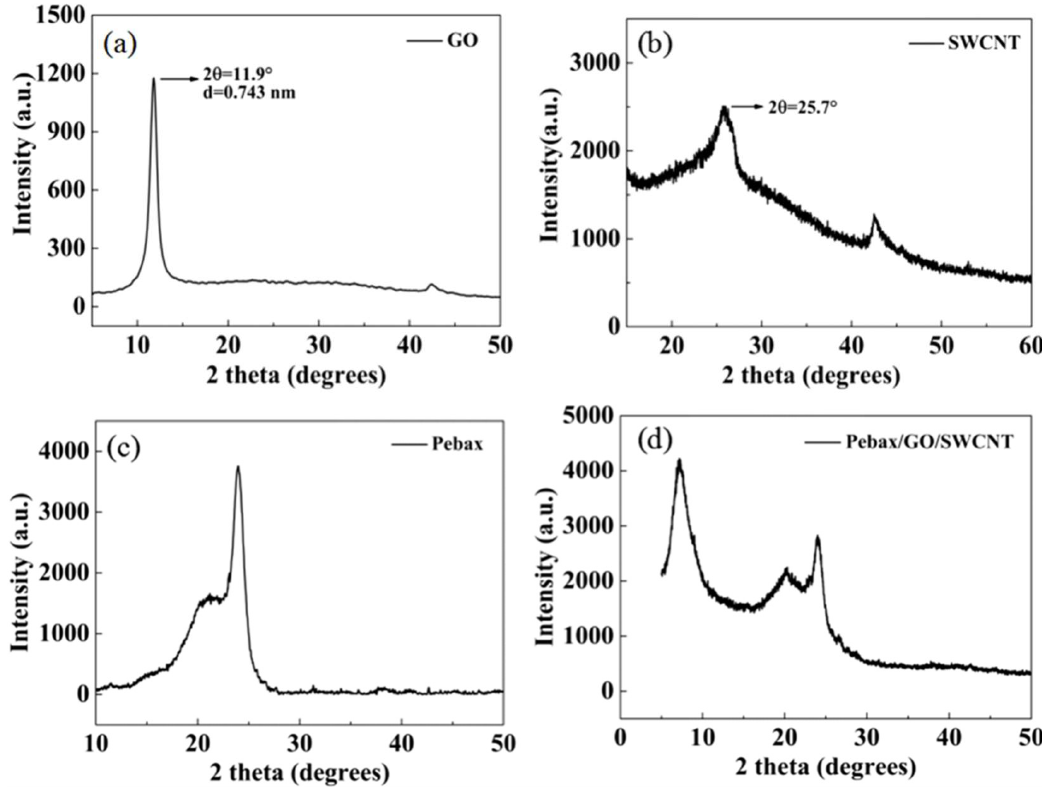
Figure 6. XRD of ( a ) GO, ( b ) SWCNTs, ( c ) pebax1657, ( d ) GO/SWCNTs/Pebax1657.